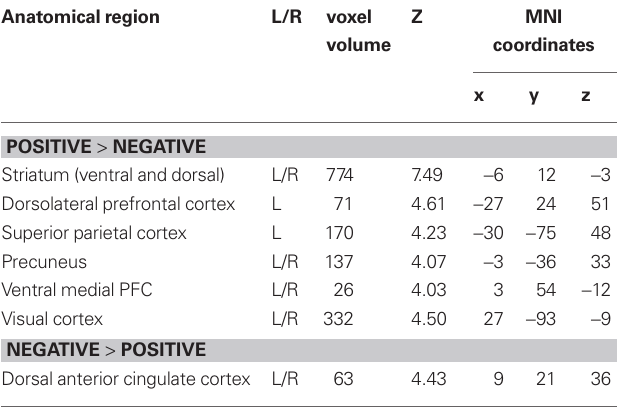
FIGURE 2 | (A) Regions from the (positive vs. negative feedback) contrasts across all participants (B) Parameter estimates and standard errors for positive and negative feedback that followed either the correct or the alternative rule